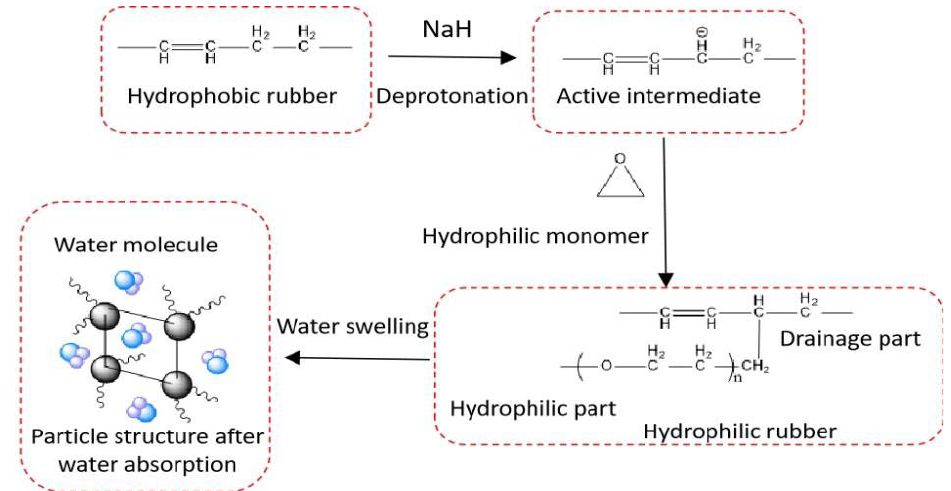
Figure 1. Synthetic reaction principle and expansion diagram of water swellable